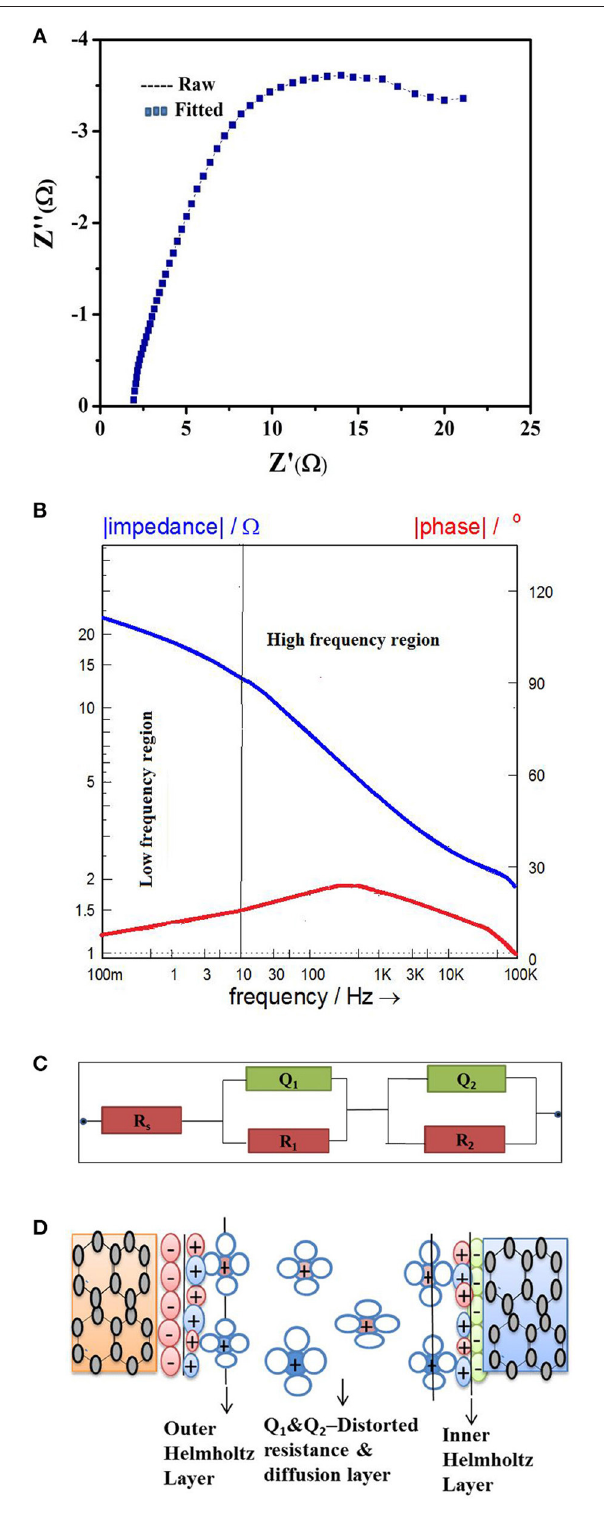
FIGURE 3 | (A) Nyquist plot for series thermocell. (B) Bode plot for series thermocell. (C) Fitted equivalent circuit for the bode and nyquist plot. (D) CPE representation at electrode/electrolyte interface at temperature gradient 1 T = 60 ◦